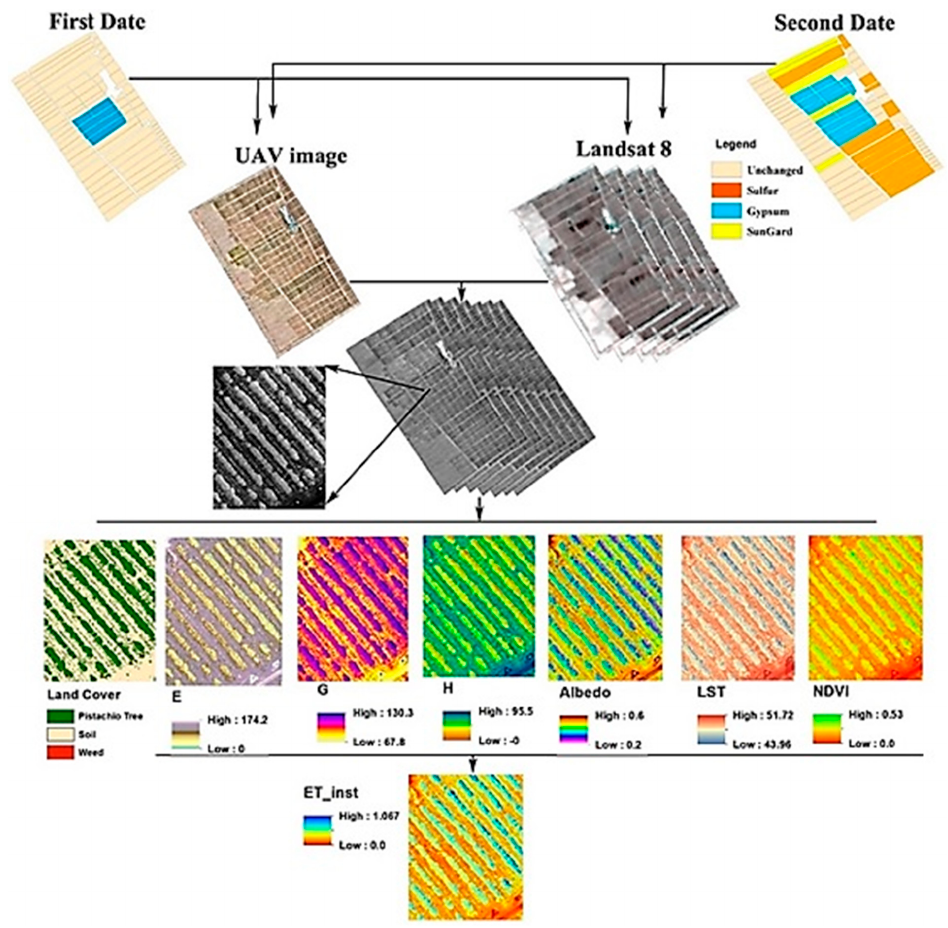
Figure 5. Outline of the research steps showing the images used and the generated images for estimating transpiration and evaporation, based on SEBAL algorithm.